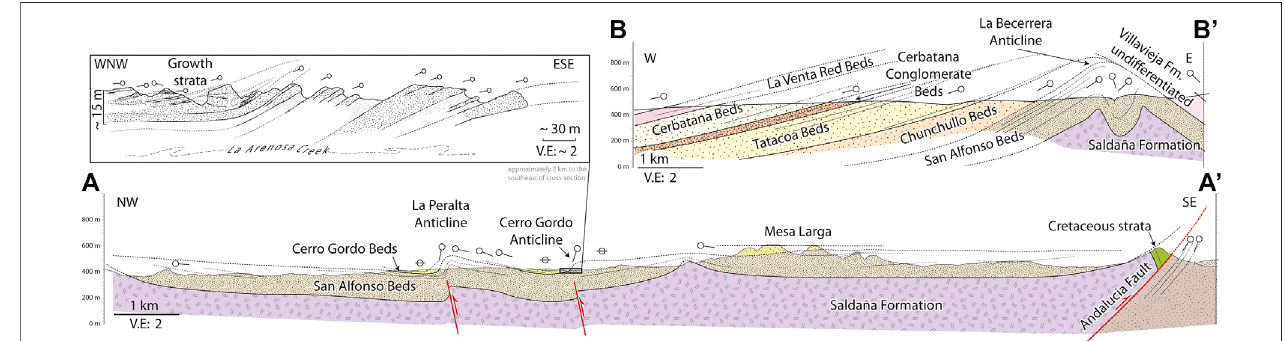
FIGURE 7 | Cross-sections of the Tatacoa Desert. (A – A ’ ) Cross-section highlighting growth strata associated to the relatively small La Peralta and Cerro Gordo anticlines (quadrangleF3-G4 in Figure 4 ).Inset: fi eld drawing ofgrowth strata alongthe Arenosa creek ∼ 2km tothe southeastof the cross-section alongthe axis ofthe